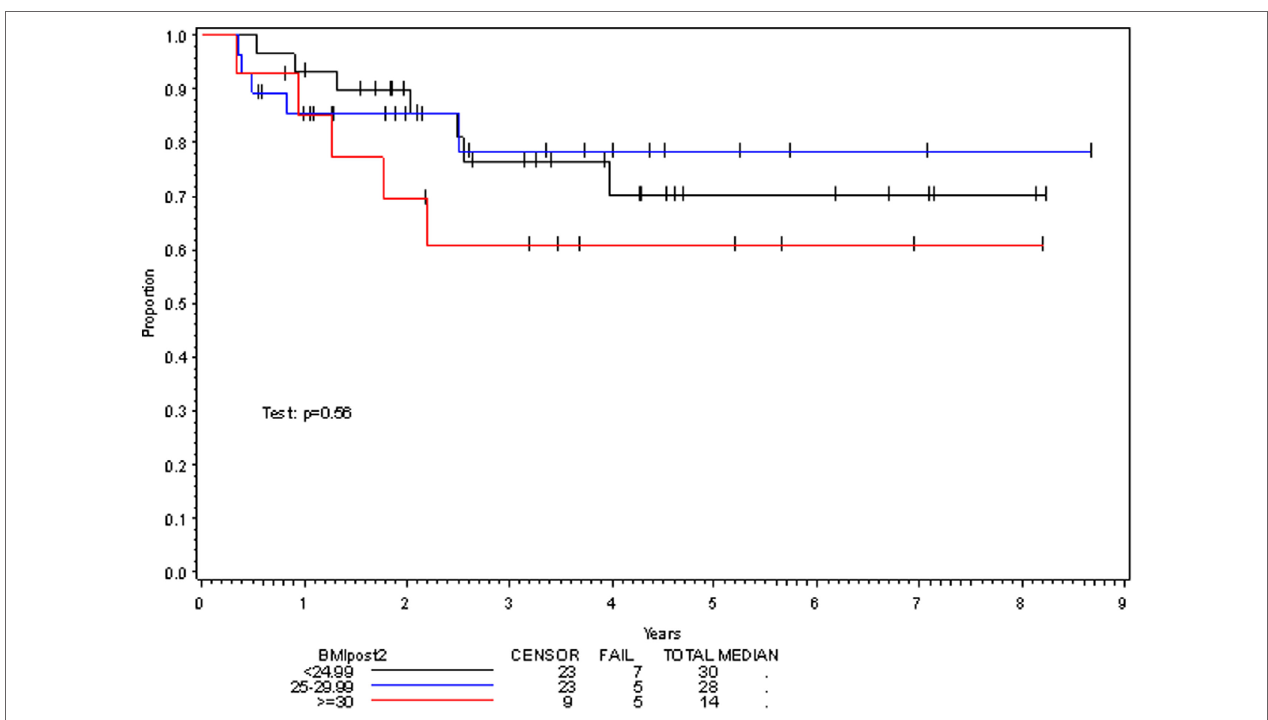
FigUre 3 | Overall survival per posttreatment BMI category.